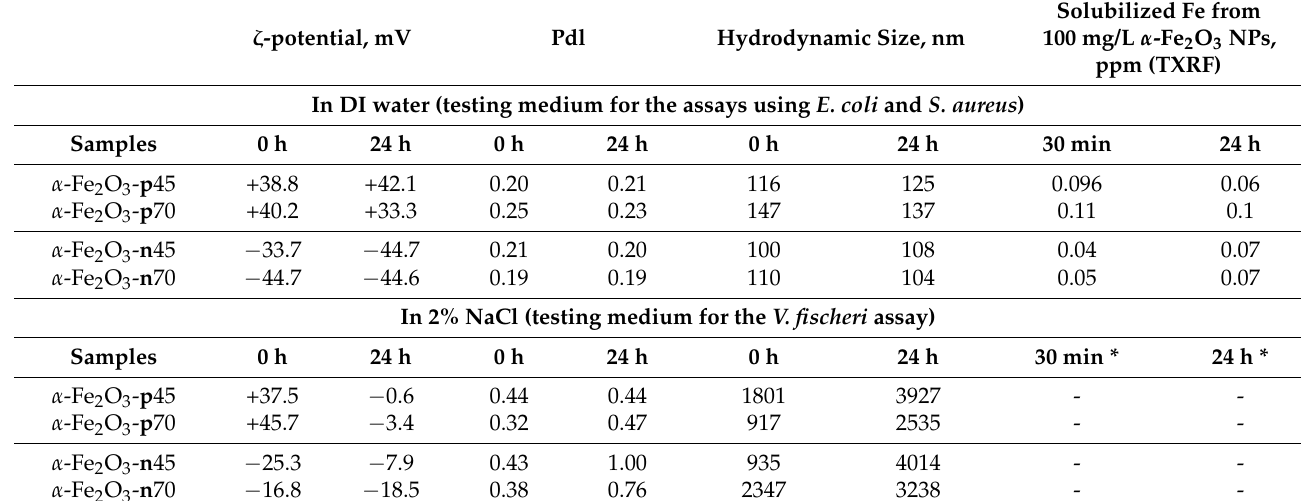
Table 3. Hydrodynamic size, ζ -potential, and solubility of hematite NPs after 0 h and 24 h incubation in the testing media used for the antibacterial